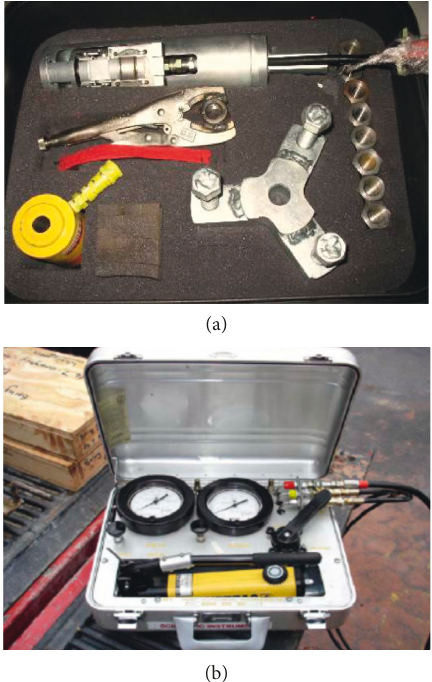
Figure 9: Rock borehole shear test apparatus: (a) direct shear apparatus; (b) lifting jack.